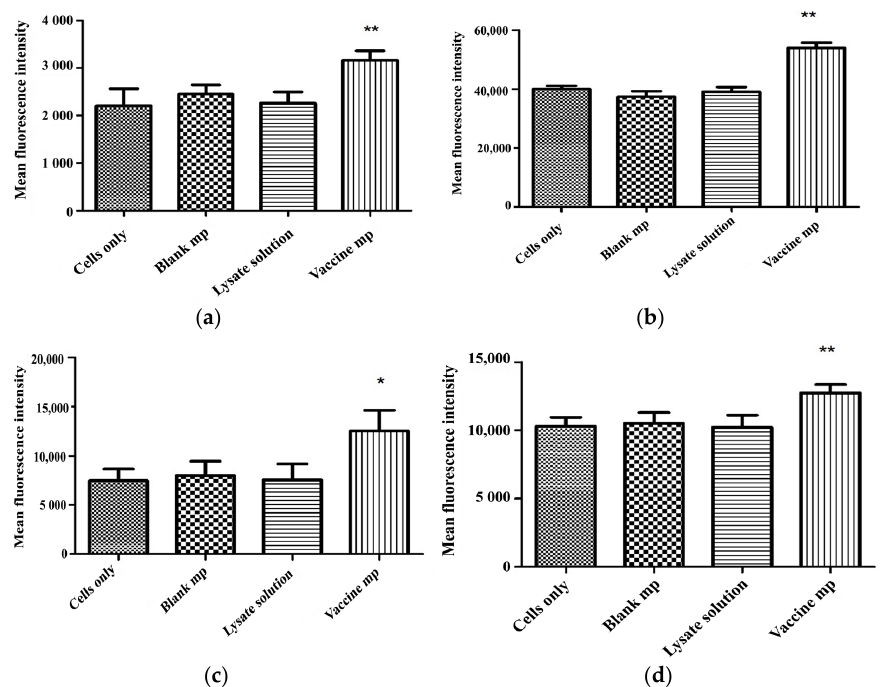
Figure 5. Analysis of the effects of microparticles on the following co -stimulatory molecules in DCs: ( a ) CD40, ( b ) CD86, ( c ) MHC I, ( d ) and MHC II. DCs (DC 2.4) (300,000 cells) were incubated with 300 µg of vaccine microparticles for 16 h. Whole cell lysate containing TAAs (30 µL of 1 mg/mL solution) and 300 µ g of blaTnk microparticles were used as the control. Vaccine-loaded microparticles induced a significantly higher expression of CD40 (*, p < 0.05), CD86, MHC I and MHC II (**, p < 0.01) than the control